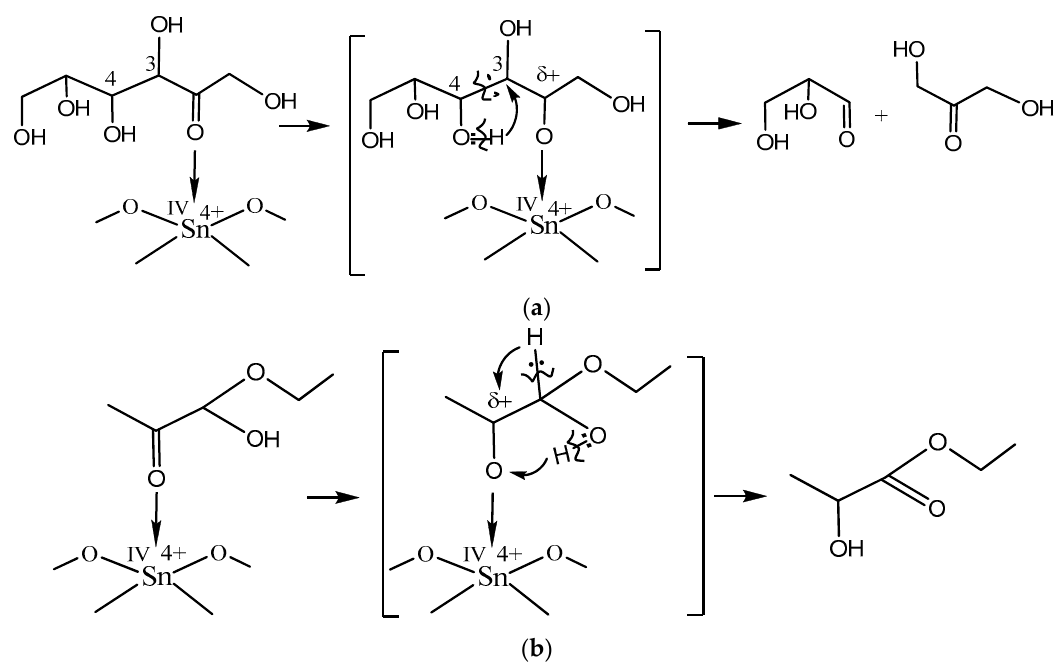
Scheme 1. Possible schemes of fructose decondensation ( a ) and the rearrangement of hemiacetal into ethyl lactate ( b ) on acid IV Sn 4+ L-sites.